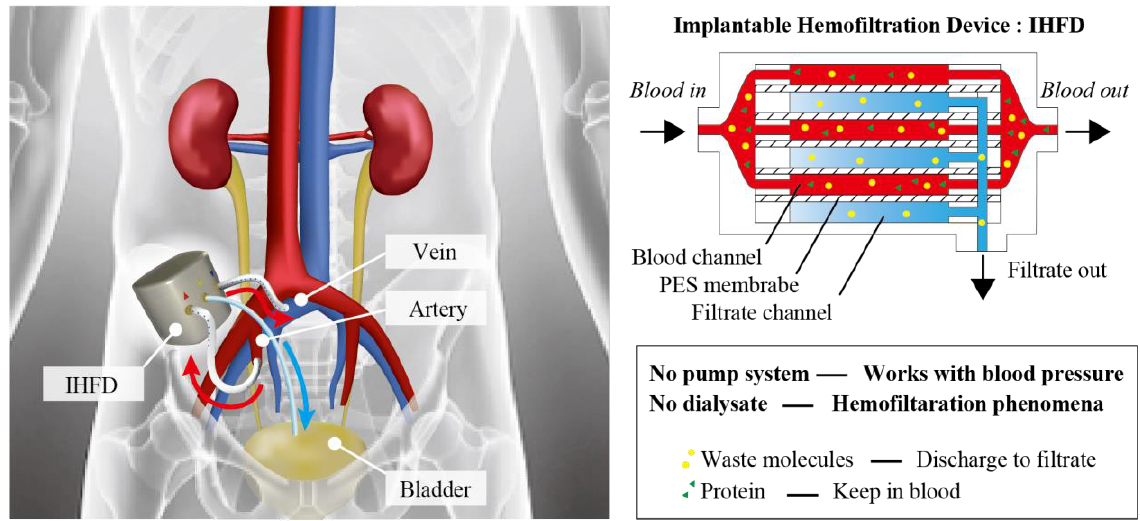
Figure 1. Concept of implantable hemofiltration device (IHFD). The device is connected to artery and vein and removes water and wastes from blood by hemofiltration. The filtrate is brought to bladder and discarded as urine. IHFD works with blood pressure and does not require a pump system. IHFD, which continuously removes water from chronic kidney disease patients, reduces the frequency of their hospital visits, alleviates the water intake restriction, and thus, drastically improves their quality of life.